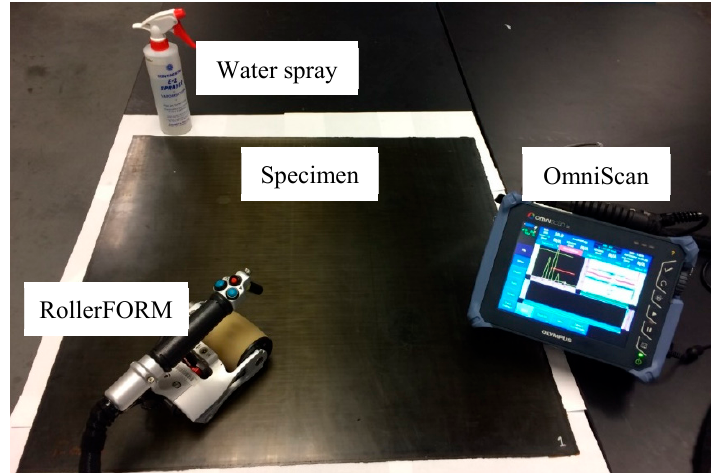
Figure 4. Experimental setup of the ultrasonic detection of the composite specimens.